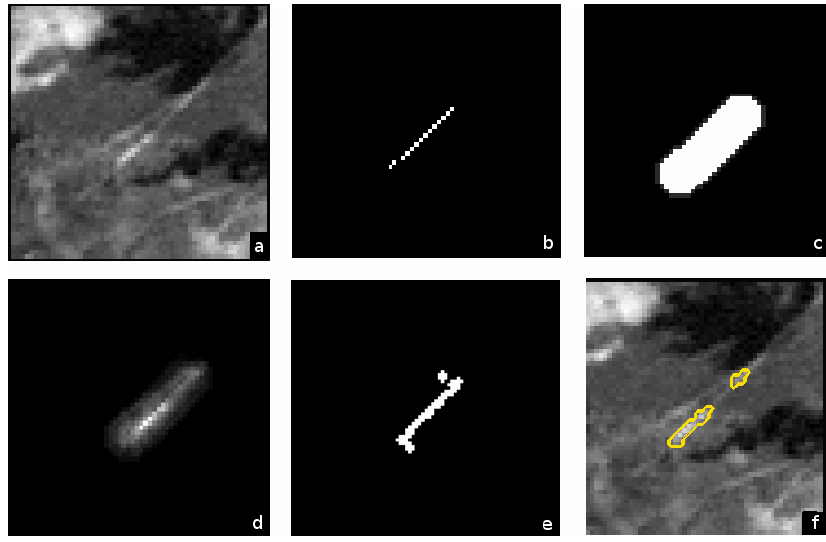
Fig. 11. Process of selecting the contrail pixels. (a) Original BTD image. (b) Line from Step I. (c) Mask labeling the pixels around the line that lie within a given distance, D ij . (d) Mask combining the distance information and the BTD signal, BTD ij · D ij . (e) Mask containing information about the maxima of each line of the image, DIL ij . (f) Pixels resulting after combining masks M 1 , M 2 and M 3 and performing the clustering test.